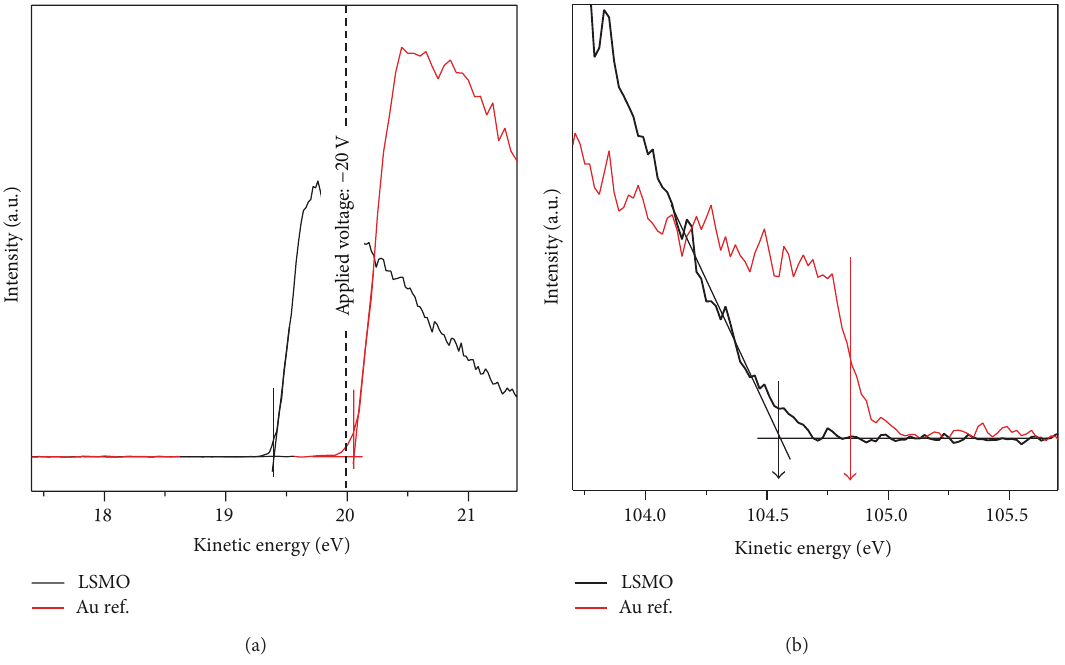
Figure 6: (a) Secondary cut-off and (b) valence band spectrum (in kinetic energy) of LSMO thin film and reference Au.